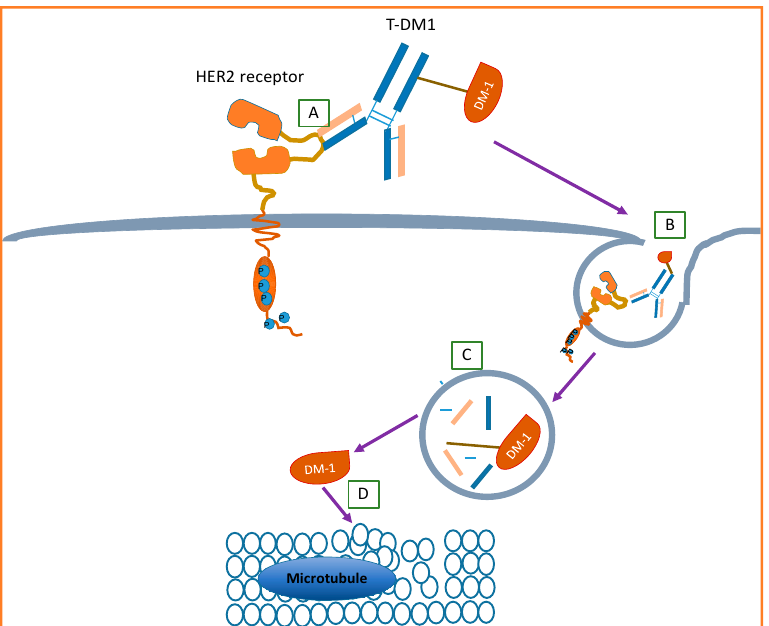
Figure 10. Potential action mechanism of T-DM1. ( A ) Trastuzumab specifically recognizes and binds to extracellular domain of HER2; ( B ) induced passive endocytosis of the formed complex of trastuzumab and HER2; ( C ) the complex may undergo a degradation process to separate the DM-1 from the complex; and ( D ) the liberated DM-1 exerts its cytotoxicity on the microtubule. Modified based on the work contributed by Martinez et al. [94].